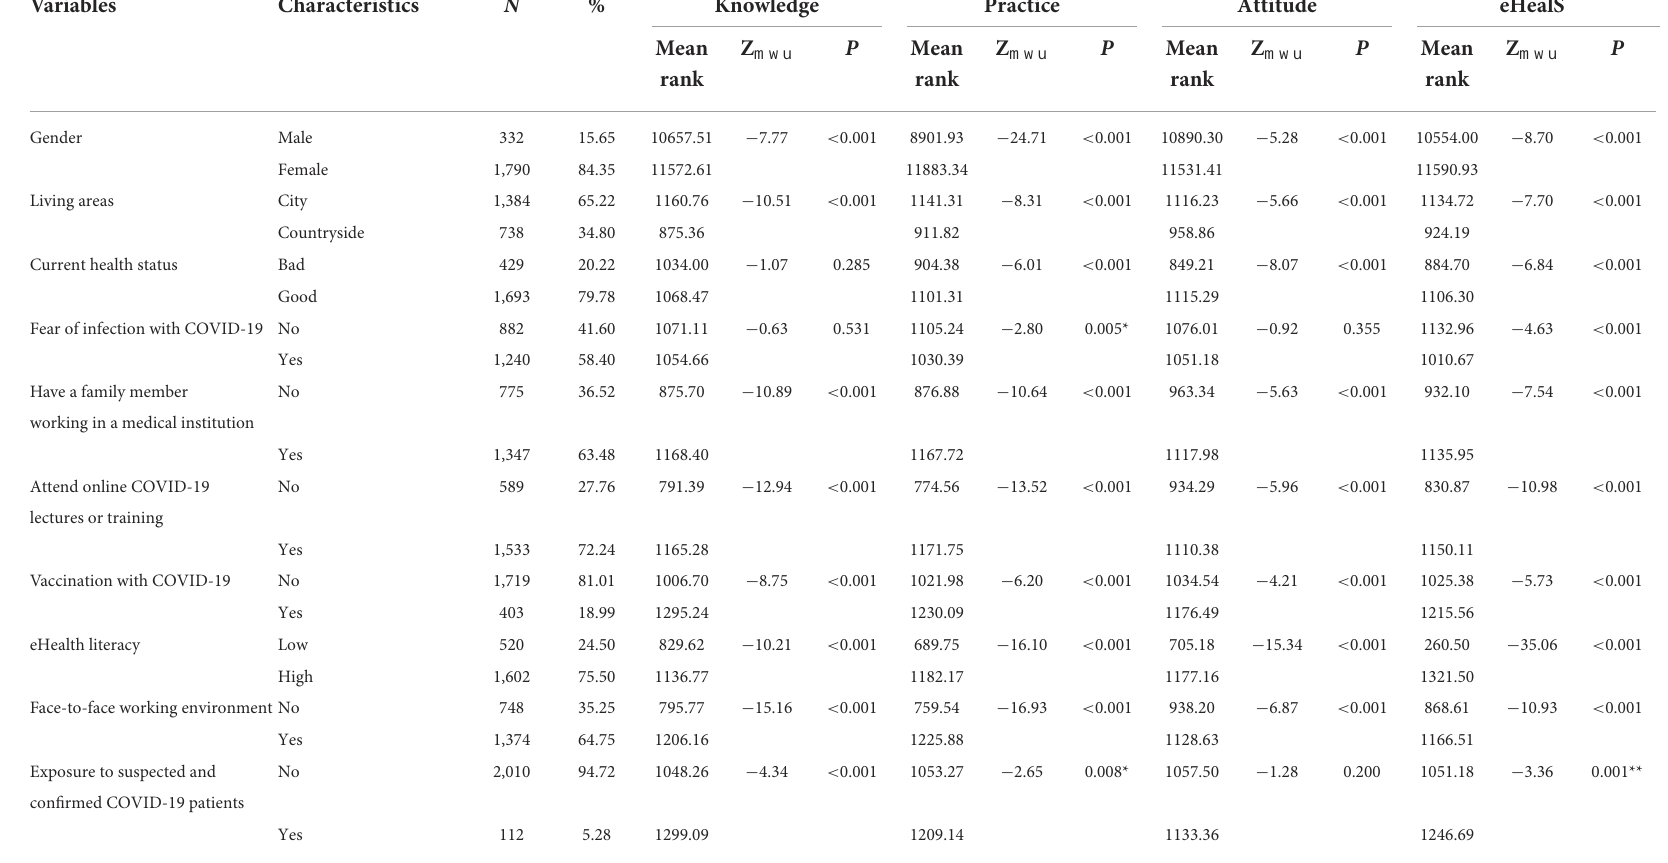
TABLE 3 Level of knowledge, attitude, and prevention behavior according to demographic characteristics ( N =